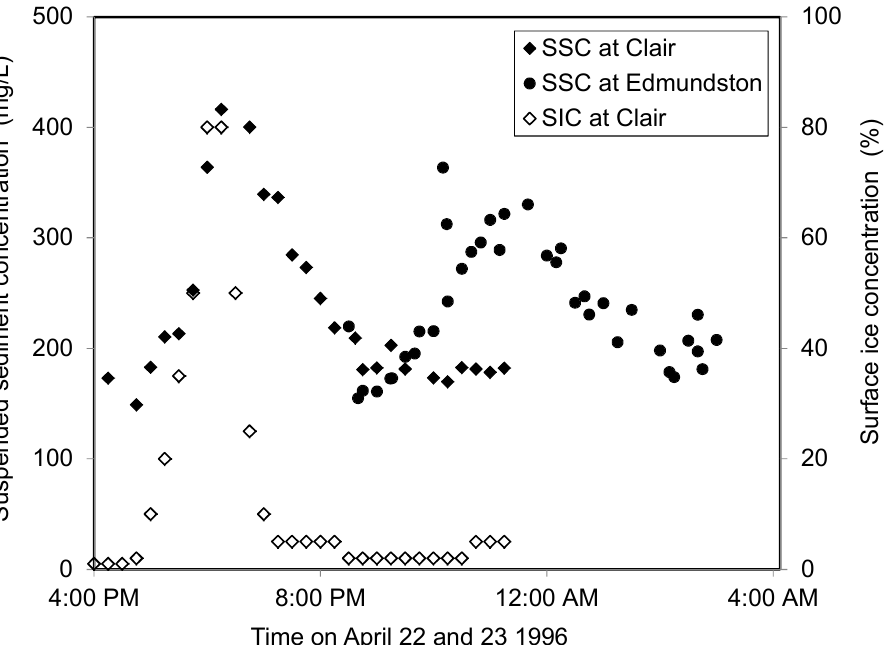
Figure 10. Pulse propagation and dispersion, Saint John River, 22 and 23 April 1996. The Clair bridge is located ~34 river km upstream of the Edmundston bridge. The variation of surface ice concentration (SIC) at Clair is also shown. From [53], Crown copyright, published by Elsevier. Javes produce much higher concentrations than would be expected from the gradual river response to runoff, ranging from 4.2 to 6.5 times the runoff-generated peaks in the Saint John River and attaining values of ~1000 mg/L or 1 g/L [53]. For the Athabasca River